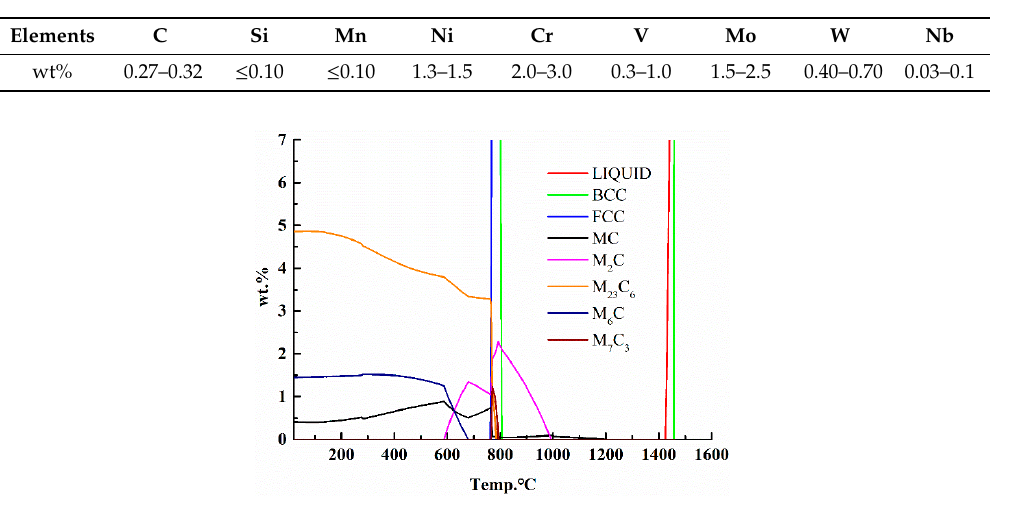
Figure 6. Alloy 2 equilibrium phase diagram.